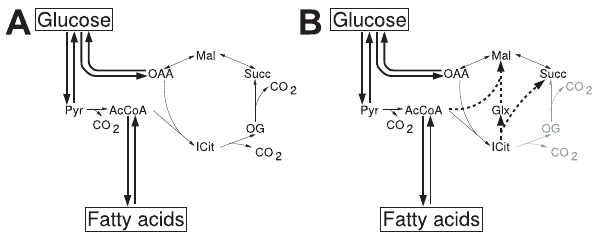
Figure 1. Classical scheme of the interconversion between glucose and fatty acids in humans. A While the conversion of glucose into fatty acids is possible, the product of b -oxidation of even- chain fatty acids, acetyl-CoA, can only enter the TCA cycle by reaction with oxaloacetate to citrate. However, in order to replenish the oxaloacetate consumed in this reaction, the TCA cycle has to be used resulting in the release of two carbon atoms in form of carbon dioxide. Hence, while two carbon atoms enter the TCA cycle in form of acetyl- CoA two others are lost and a net production of oxaloacetate which would be required for gluconeogenesis is not possible. B In some organisms the carbon releasing steps of the TCA cycle can be bypassed using the glyoxylate shunt (thick dotted reactions). In consequence, one mole of oxaloacetate can be produced from two mole of acetyl-CoA, allowing for gluconeogenesis from fatty acids. A list of abbreviations can be found in Table S1.